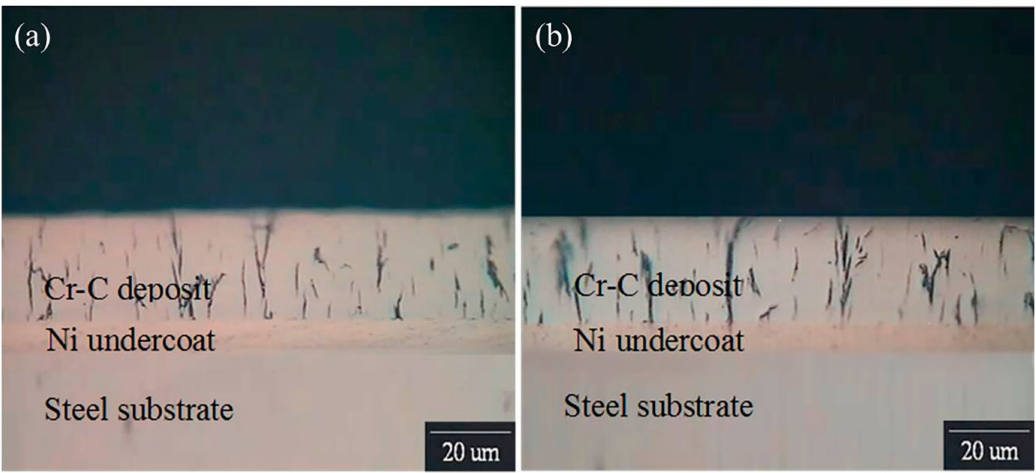
Figure 2. Cross-sectional micrographs of the ( a ) non-heated and ( b ) heat-hardened Cr–C / Ni-coated